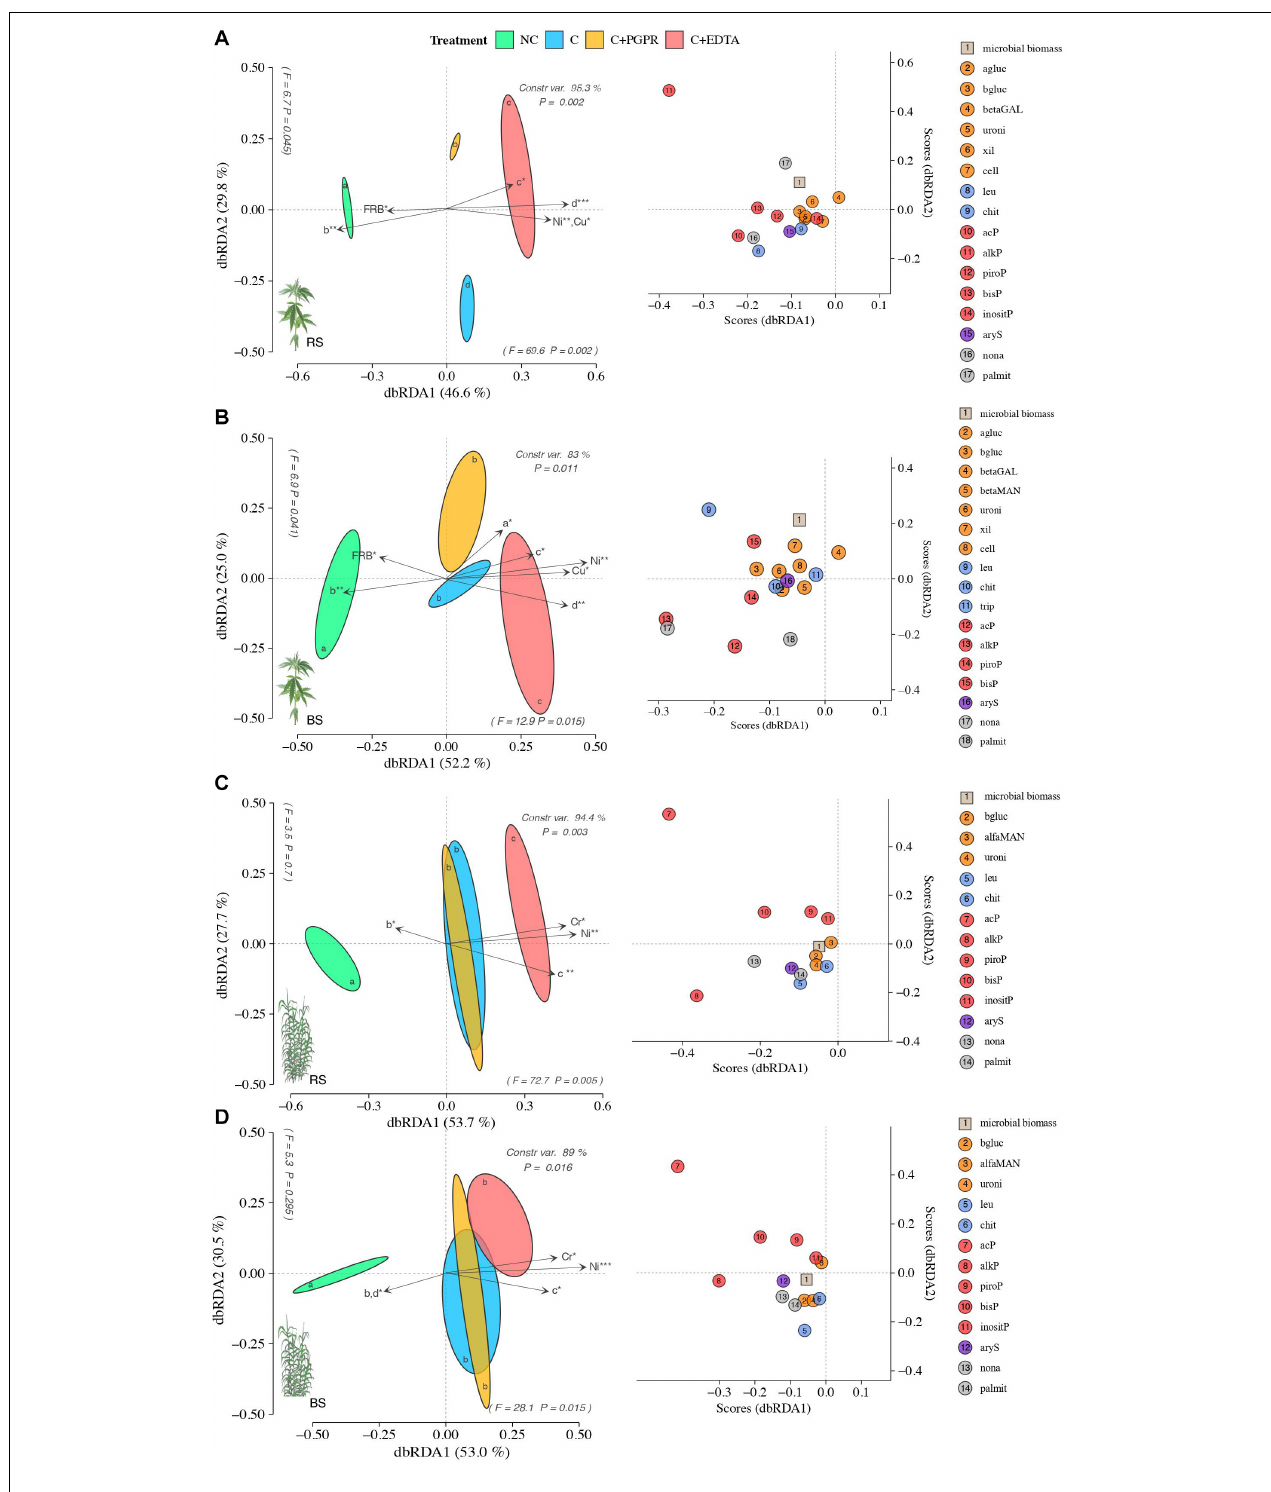
FIGURE 5 | Distance-based redundancy analysis (dbRDA) plots showing shifts in enzyme activities of RS (A , C) and BS (B , D) of hemp (A , B) and giant reed (C , D) among treatments. Arrow indicates environmental variables with significance level (* < 0.05, ** < 0.001, *** < 0.001). Species scores corresponding to the dbRDA plots (coordinates for enzymes included in model) are reported in the scatter plots on the right. Letters within ellipses denote significant differences (Bonferroni’s test, P = 0.05) in EA similarity matrices among fertilizers as assessed by permutational multivariate analysis of variance (PERMANOVA).